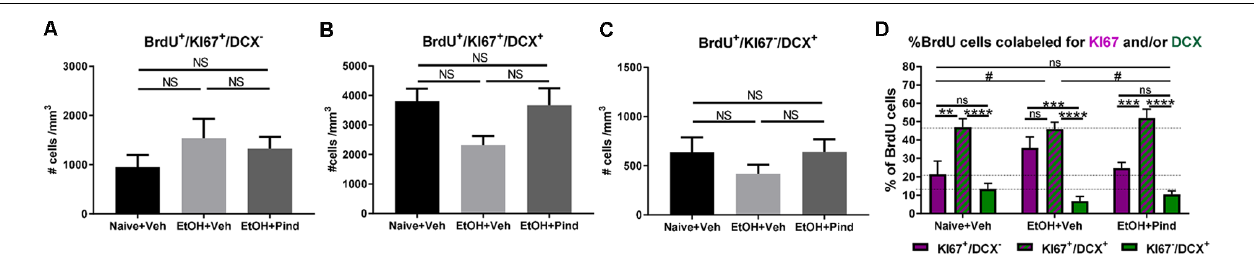
FIGURE 3 | Effects of pindolol on alcohol-induced impairments in the proportion of newborn proliferating cells, newborn proliferating immature neurons and newborn non-proliferating immature neurons. The density of BrdU + /Ki67 + /DCX − newborn proliferating cells is not affected by alcohol consumption or pindolol pre-treatment (A) . Long-term alcohol drinking or pindolol also have no effect on the density of BrdU + /Ki67 + /DCX + newborn proliferating immature neurons in the DG, however a strong trend towards reduction is seen in the alcohol group as compared to alcohol naïve controls (B) . The density of BrdU + /Ki67 − /DCX + newborn non-proliferating immature neurons is not affected by alcohol consumption or pindolol pre-treatment (C) . (A–C) Data are presented as mean density of cells per mm3 of granular layer ± SEM; n = 5–6 mice/group, 5–6 dentate gyri/mouse (one-way ANOVA followed by Bonferroni’s post hoc analysis). Long-term alcohol consumption impacts the proportion of newborn proliferating cells, newborn proliferating immature neurons, and newborn non-proliferating immature neurons as compared to alcohol naïve controls which is restored by chronic pindolol treatment (D) . Data are presented as mean percentage of BrdU + cells ± SEM. ∗∗ p < 0.01; ∗∗∗ p < 0.001, ∗∗∗∗ p < 0.0001 (two-way ANOVA with Bonferroni’s post hoc test). # p < 0.05 (Chi-squared distribution analysis). ns = not significant, p > 0.05.